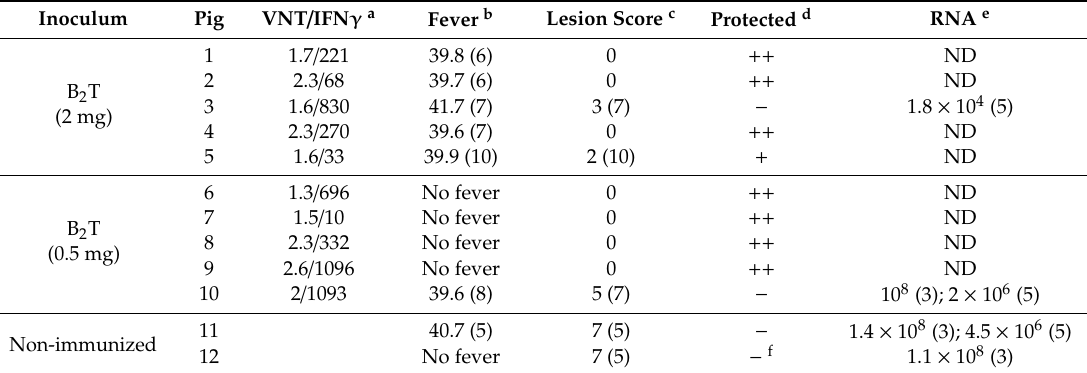
Table 2. Evidences for protection in immunized